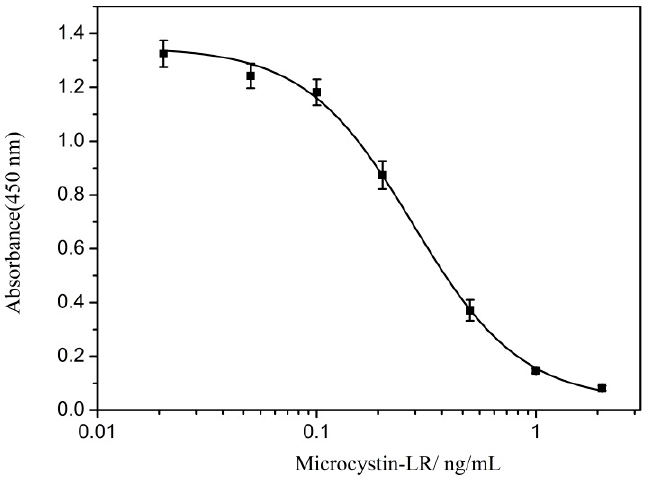
Figure 1. Standard curve for measurement of